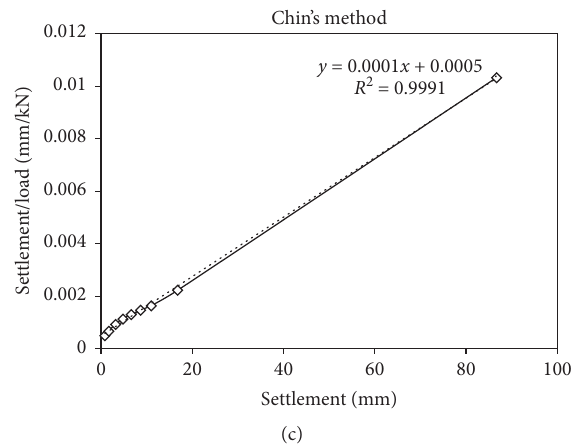
Figure 24: Interpretations of (a) the double tangent method; (b) Davisson’s method; and (c) Chin’s method.